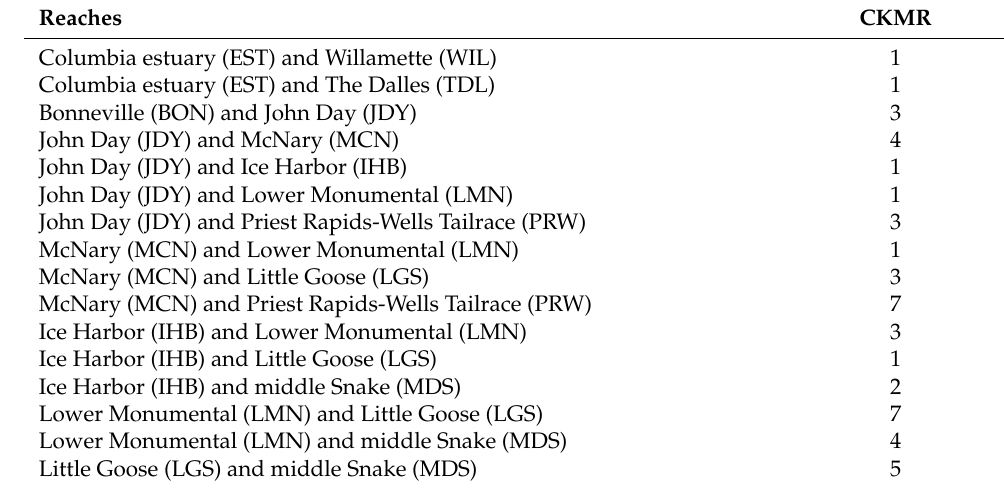
Table 4. Transgenerational dispersals across reaches inferred from close-kin mark-recapture (CKMR), identified as the intersection of high ML relatedness and high probability of